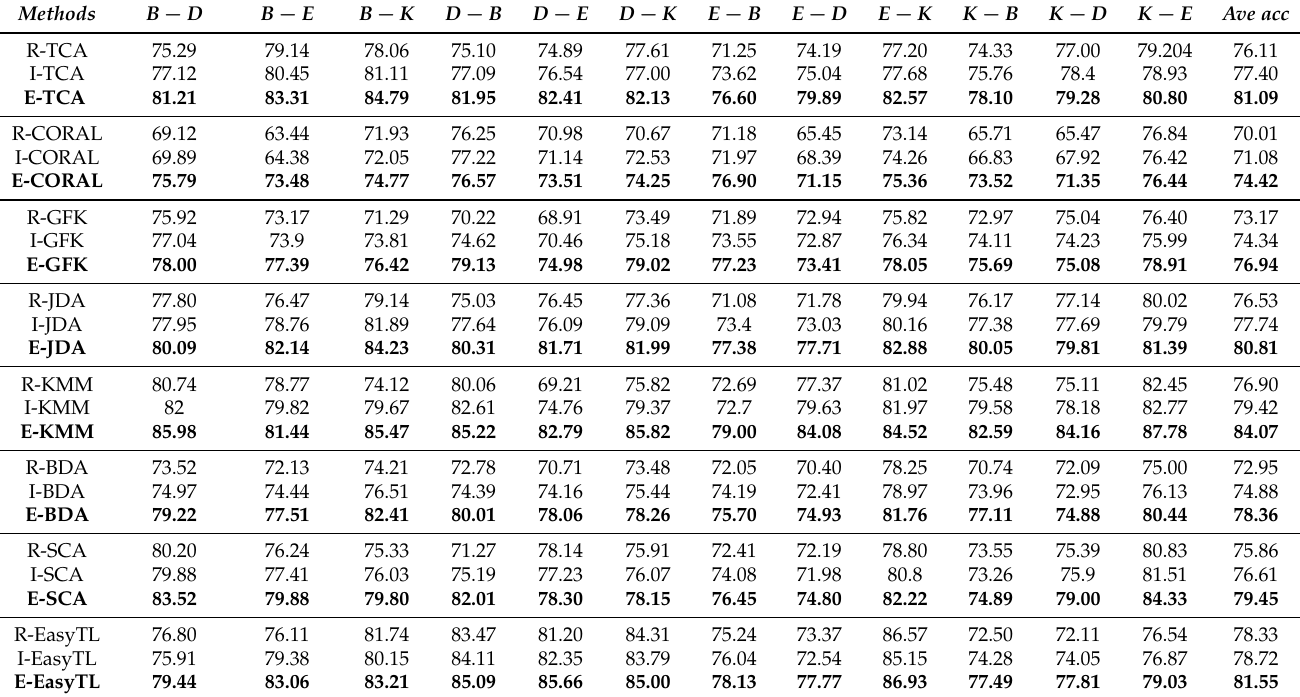
Table 4. Cross-domain sentiment classification accuracies of the text dataset generated by